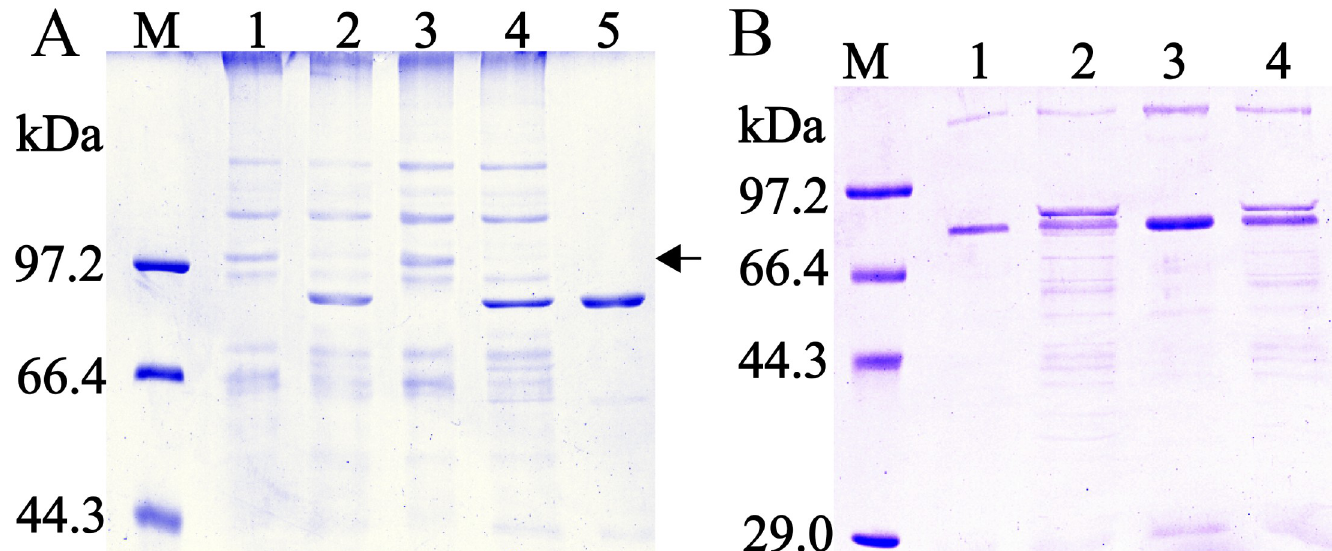
Fig 5. Digestion of collagen IV and IgM. The substrate including collagen IV (A) and IgM (B) was incubated with rTsASP2. The band of approximately 98-kDa collagen IV was degraded (arrow), and degraded IgM fragments were observed compared with untreated IgM. M: protein marker; lanes 1 and 3: substrates in buffer alone; lanes 2 and 4: substrate + rTsASP2; lane 5: purified rTsASP2; lanes 1 and 3: pH 2.5; lanes 2 and 4: pH